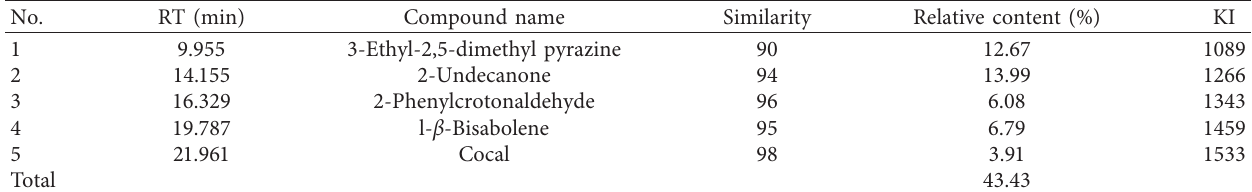
Table 1: Compounds and relative percentage of P . geesteranus